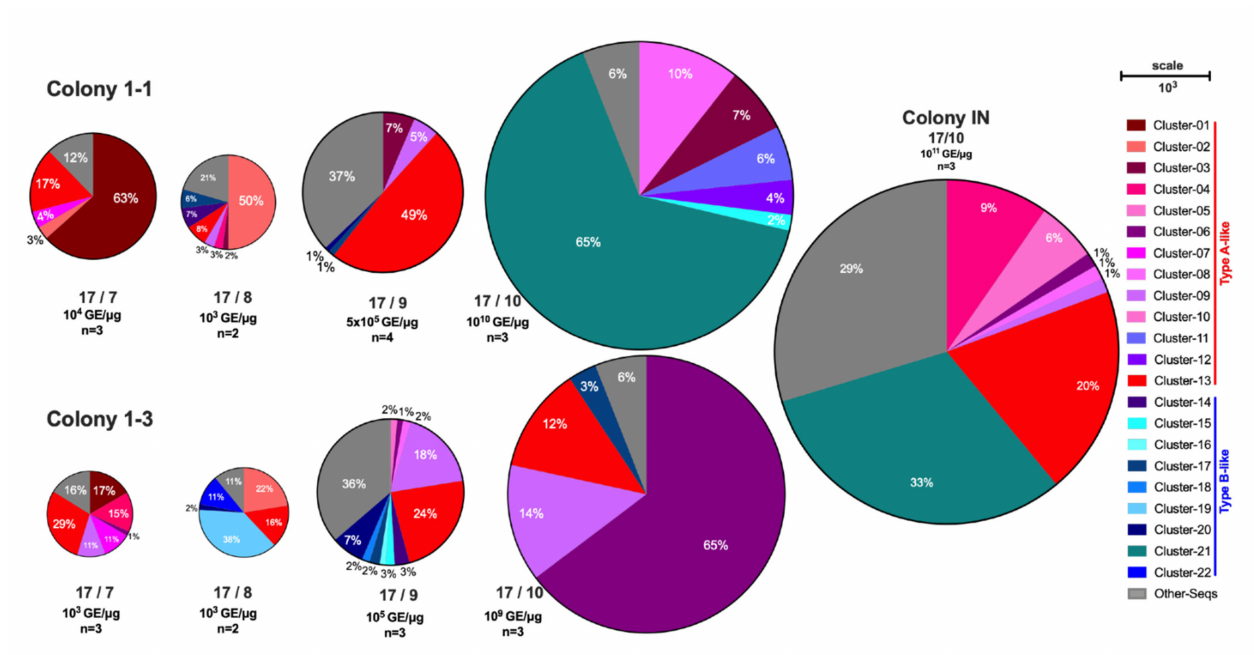
Figure 5. Visualisation of haplotype diversity and scale of virus level for each time point for Colony 1-1 and 1-3. Each pie chart represents a single time point for one colony, with all haplotype variants from multiple bees sequenced individually shown. The assigned clusters were coloured shades of red if they best matched Type A reference genomes and blue if they best matched Type B reference genomes. The size of the pie is determined by the DWV genome equivalents, shown below each pie, scaled using the circle diameter. The percentage that each haplotype makes up is shown in each segment. The segments reflect the granularity determined by ShoRAH and it is possible that other variants not detected by ShoRAH are present at low levels. The number of individual samples collated for each time point are shown below the virus titre as n =